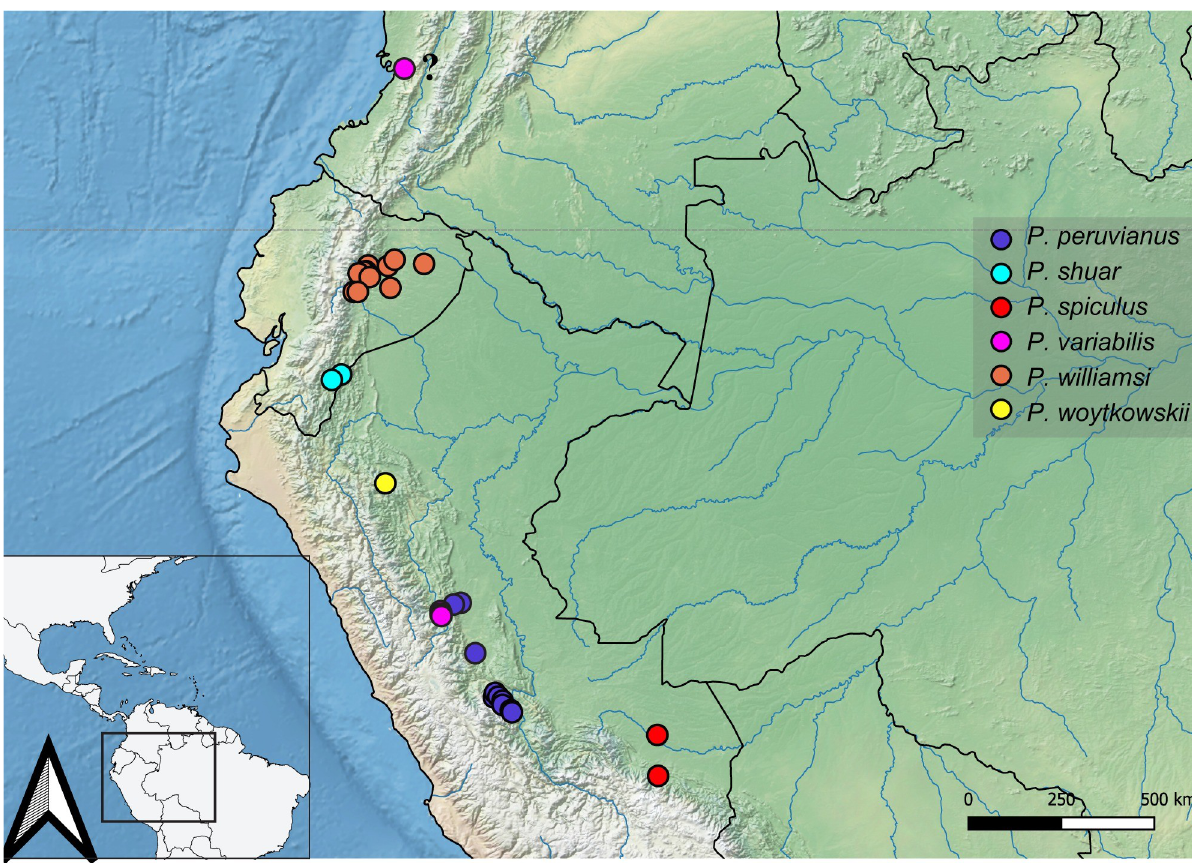
Fig 40. Map showing the geographical distribution of species of P . peruvianus , P . shuar , P . spiculus , P . variabilis , P . williamsi , P . wotkowskii . Spatial data from Natural Earth